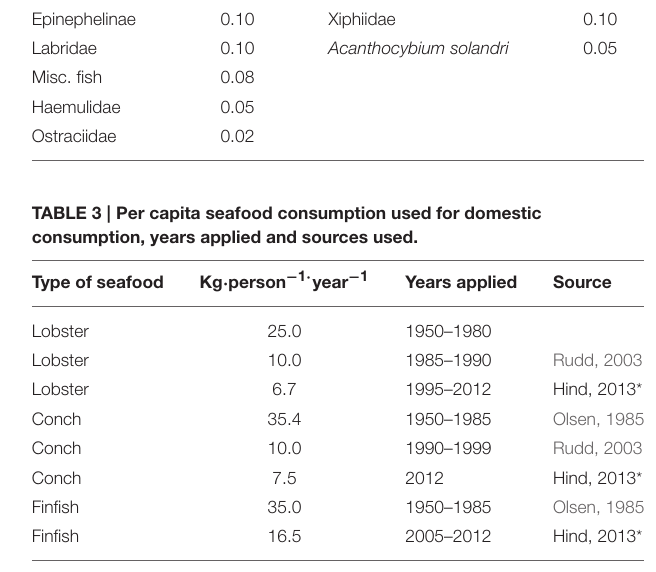
Linear interpolations used to estimate missing years. * Hind (unpublished data).